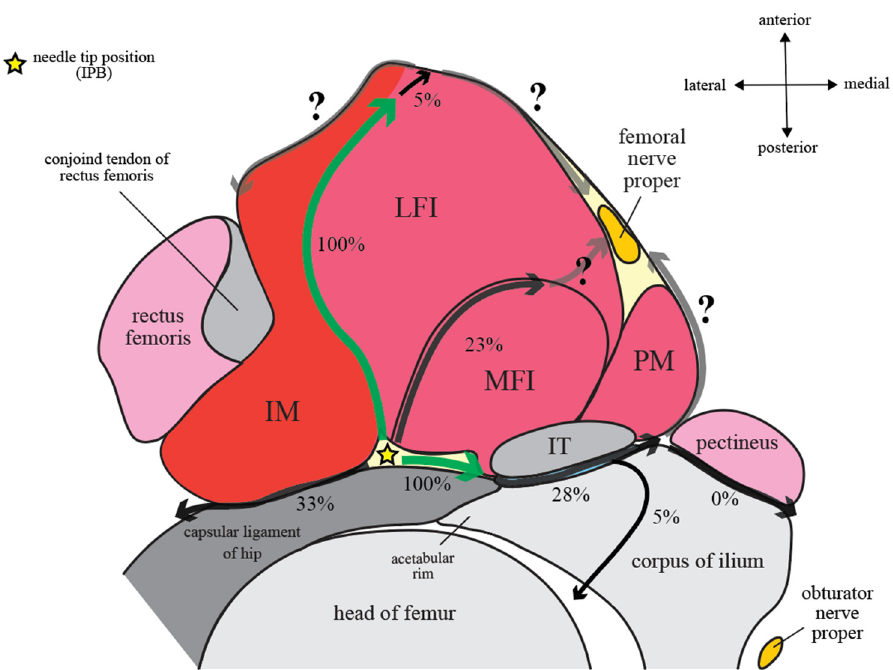
Figure 4. The injectate spread behavior after 5 mL iliopsoas plane block (IPB): Solid arrowed lines represent the routes of spread observed in Nielsen et al.’s IPB volunteer trial [7], while the faded arrowed lines represent the theoretical routes of spread as the injectate volume is increased. Each solid arrowed line is also shown with its respective occurrence frequency observed in the trial [7]. The predominant route of spread (100%) is along the L-shaped iliopsoas plane (IP), comprised of a horizontal fascial plane (i.e., the ligamentous IP) and a vertical raphe between lateral fibers of iliacus (LFI) and iliacus minor (IM) (i.e., the muscular IP), and is colored in green. Lateral fascial plane spread between IM and capsular ligaments of hip toward the gluteus muscles, medial fascial plane spread into the iliopectineal bursa, iliopsoas intramuscular spread along the septum between medial fibers of iliacus (MFI) and LFI, superficial spread along the muscular IP to the anterior surface of iliopsoas complex, and intra-articular spread into hip joint via the bursal-synovium communication were observed in 33%, 28%, 23%, 5%, and 5% of the subjects, respectively. However, definite femoral nerve proper involvement was not readily observed. IT: iliopsoas tendon, PM: psoas